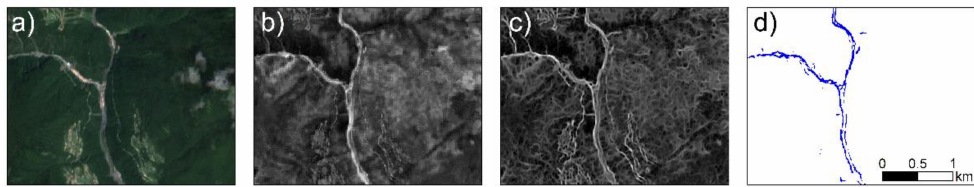
Figure 8. ASRM results in the presence of residential areas. ( a ) Original Sentinel-2 image. RGB: band 4 (Red), band 3 (Green), band 2 (Blue). ( b ) MNDWI image. ( c ) Gabor-filtered MNDWI image. ( d ) ASRM results.